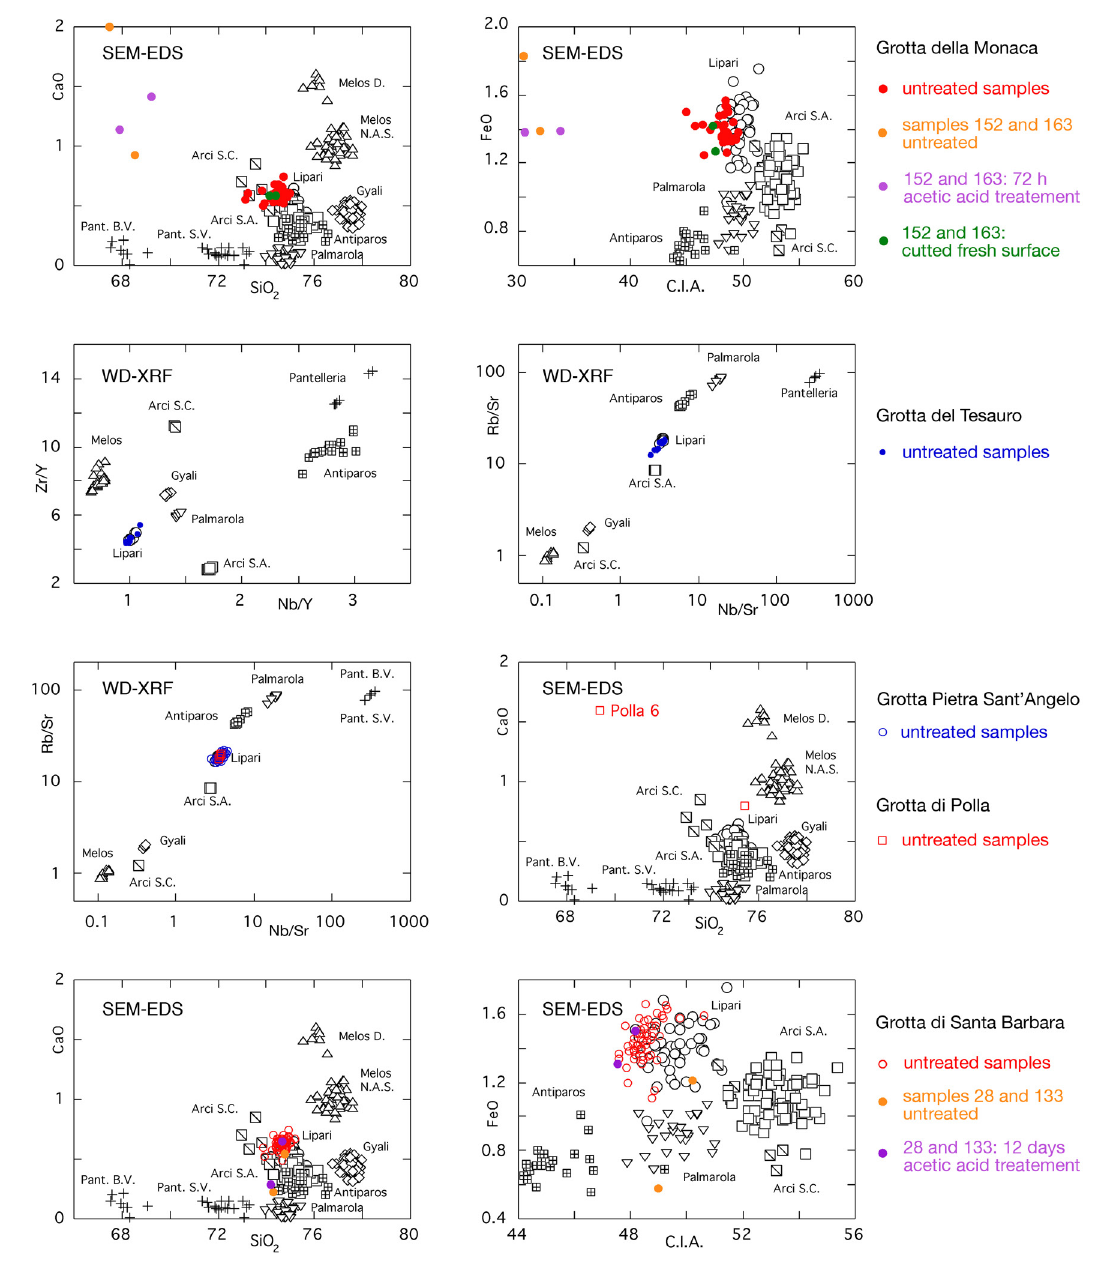
Figure 5: Plots of the SEM-EDS and WD-XRF X-ray analyses of obsidian artefacts collected in the five studied karst archaeolo- gical sites (Grotta della Monaca, Grotta del Tesauro, Grotta Pietra Sant’angelo, Grotta di Polla and Grotta di Santa Barbara) present in Southern Italy; for the explanation of the sample treatment see text. The literature data on different geological obsi- dian sources of the Mediterranean basin are from Acquafredda et al., 1999, 2018, 2019. Sub-sources outcrops: Monte Arci, S.C. = Perdas Urias; S.A. = Conca Cannas, Canale Perdera and Riu Solacera. Pantelleria, B.V. = Bagno di Venere, S.V. = Salto la Vecchia and Balata dei Turchi. Melos, D. = Demenegaki; N.A.S. = Nihia, Adamas and Sarakiniko. C.I.A. = Chemical Index